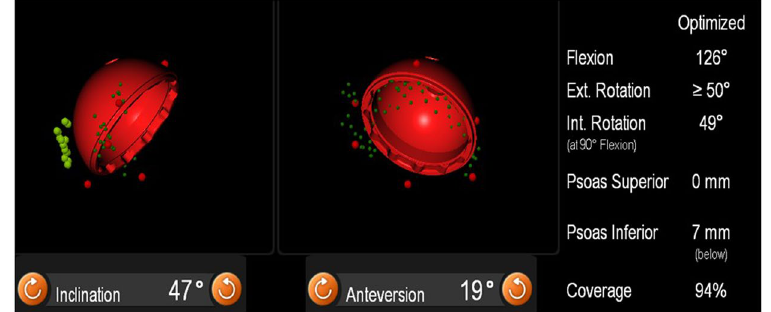
Figure 1. Optimized cup position as calculated by an intraoperative impingement detection algorithm using imageless